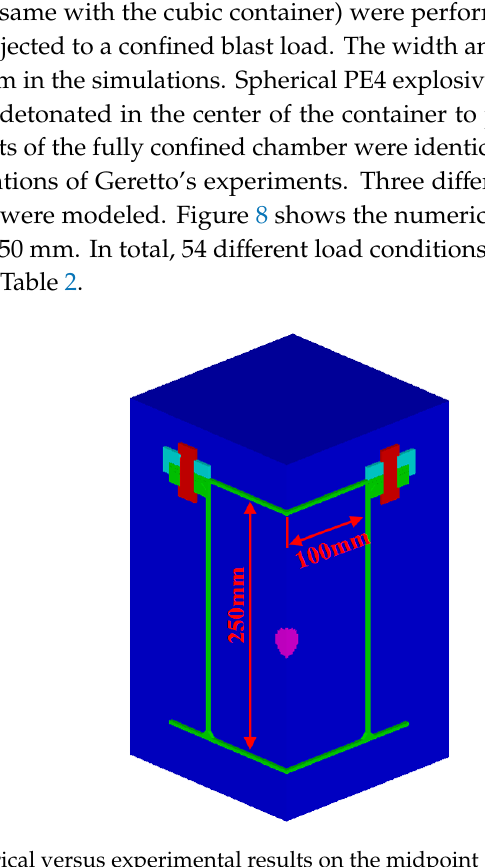
Figure 8. Numerical versus experimental results on the midpoint deflection–thickness ratio.